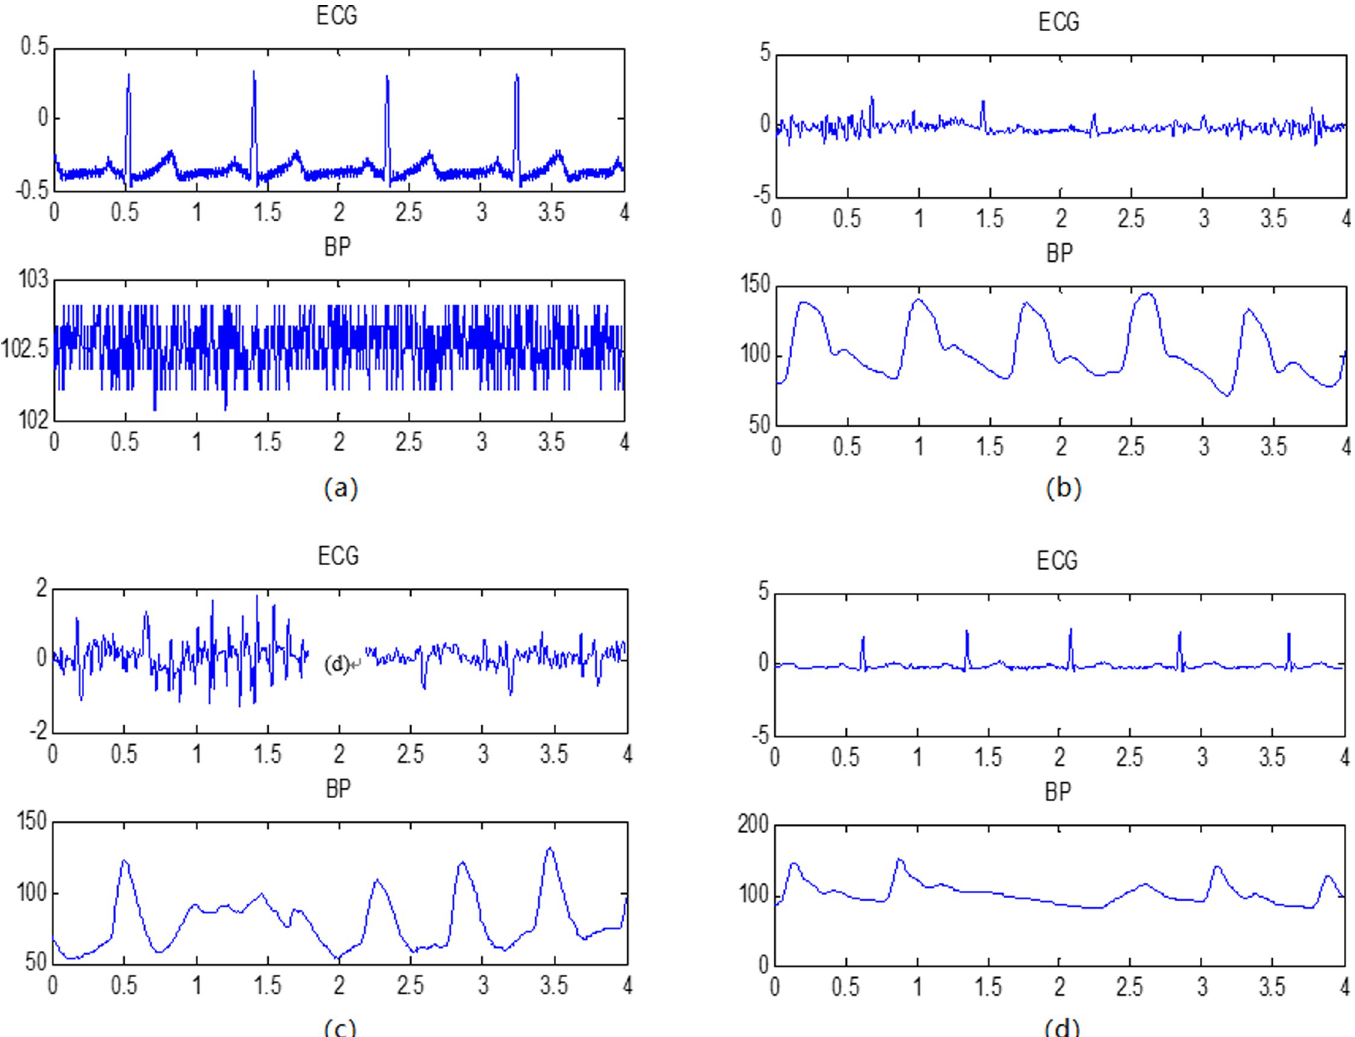
Fig 9. Different kinds of qualities on simultaneously recorded ECG and BP signals. (a) BP is not monitored; (b) (c) the BP waveform is better than the ECG waveform; (d) the ECG waveform is better.